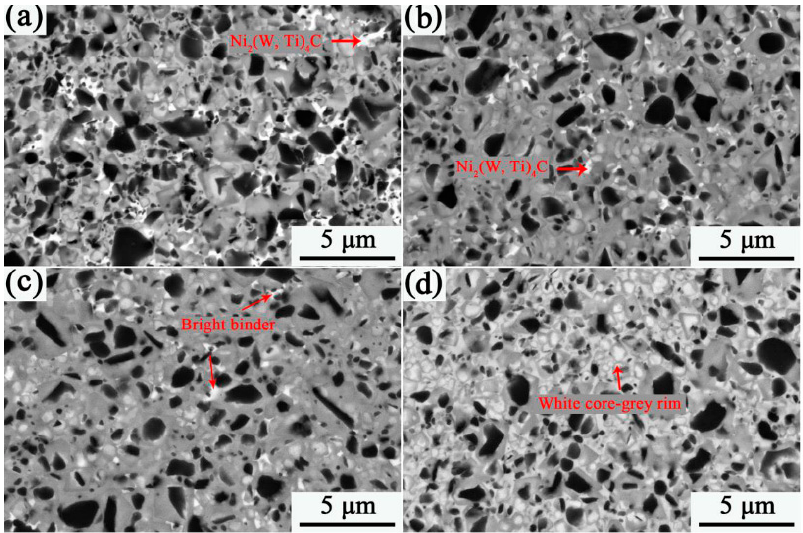
Figure 6. SEM images of V0.5 to V1.5 sintered in gas pressure sintering at 1470 °C for 1 h with 0.5 and 0.8 wt.% C. ( a ) V0.5; ( b ) V0.8; ( c ) V1.2; ( d ) V1.5. Reprinted from Ref. [83] with permission from Ceram. Int.